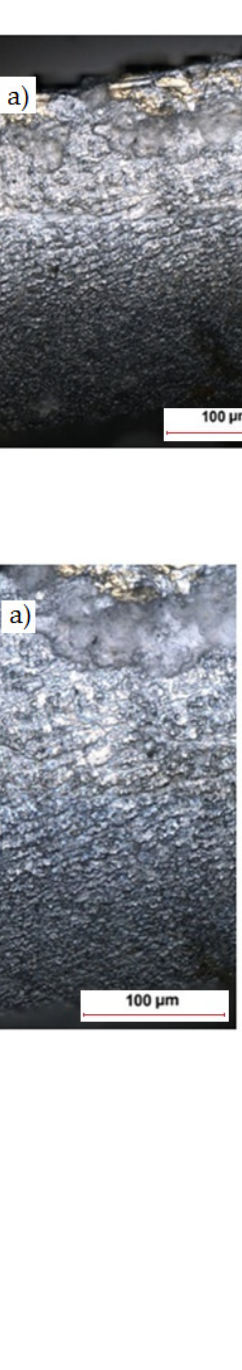
Figure 8. The view of the surface of the cut edge ( h c = 0.02 mm and v = 17.5 m/min): ( a ) surface photography, ( b ) surface topography (coated steel).